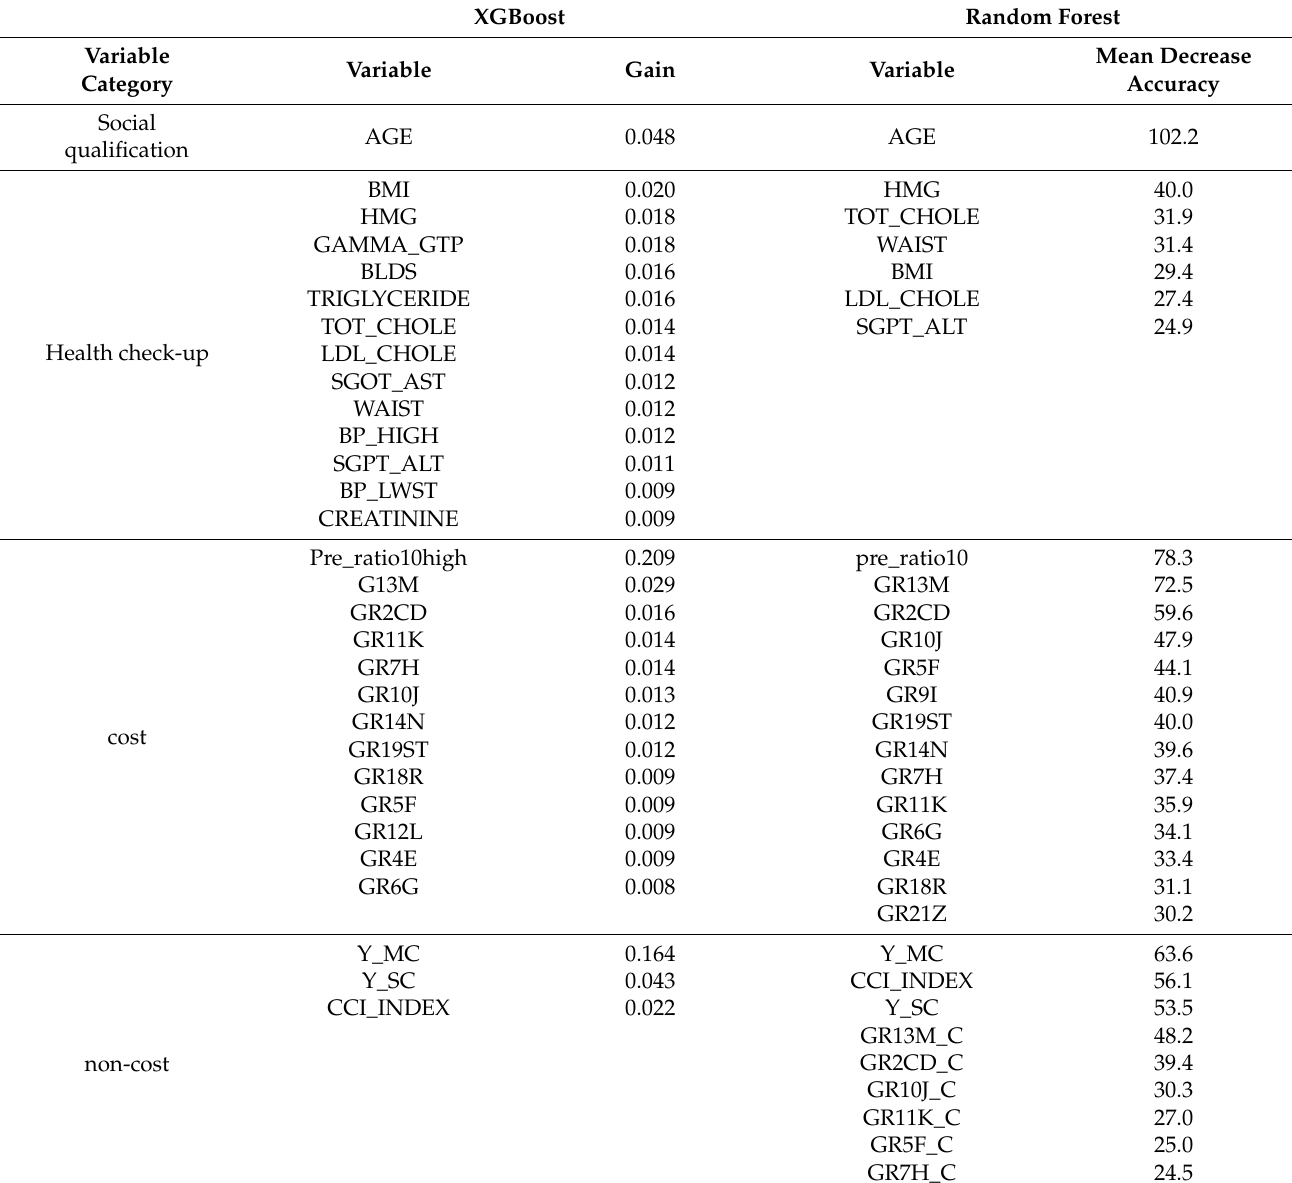
Table 7. Top 30 Variable importance (Down-sampling dataset 4) of XGBoost and Random Forest. XGBoost Random